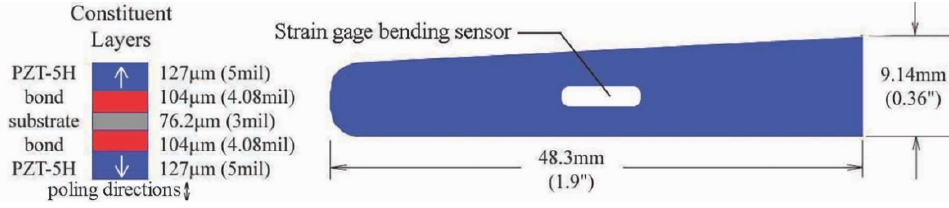
Figure 10. PBP Flexspar Element Layup.